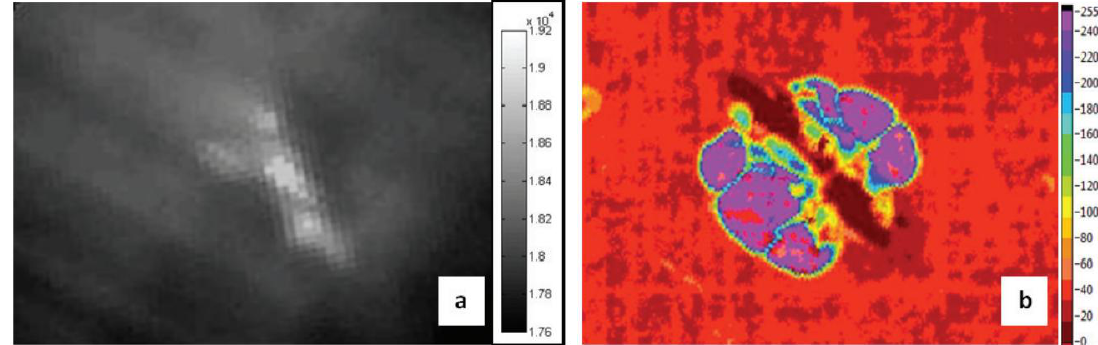
Figure 19. Comparison between eddy current stimulated thermography ( a ) and ultrasonic C-Scan ( b ) on impact damaged CFRP sample, with permission from 139.